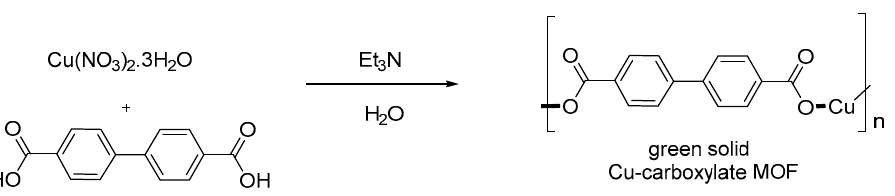
Scheme 5. Preparation of Cu-carboxylate MOF.